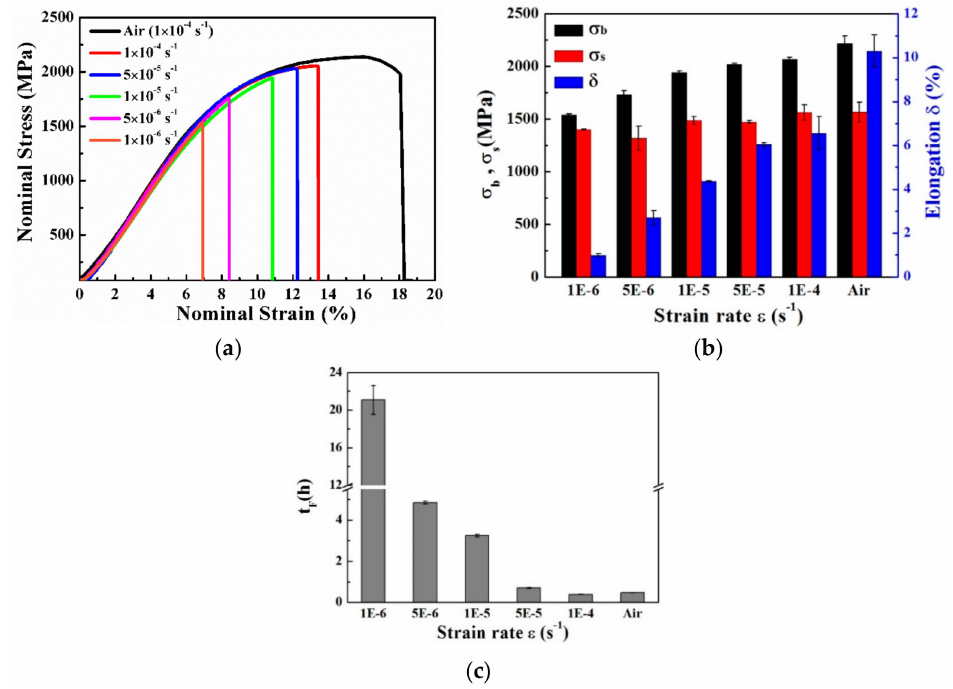
Figure 7. ( a ) The nominal stress–nominal strain curves of in-situ continuous soaking SSRT at varying strain rates (1 × 10 − 4 –1 × 10 − 6 s − 1 ); ( b ) Ultimate tensile strength σ b , yield strength σ s, and elongation δ of the steel at di ff erent strain rates; and, ( c ) Fracture time at di ff erent strain